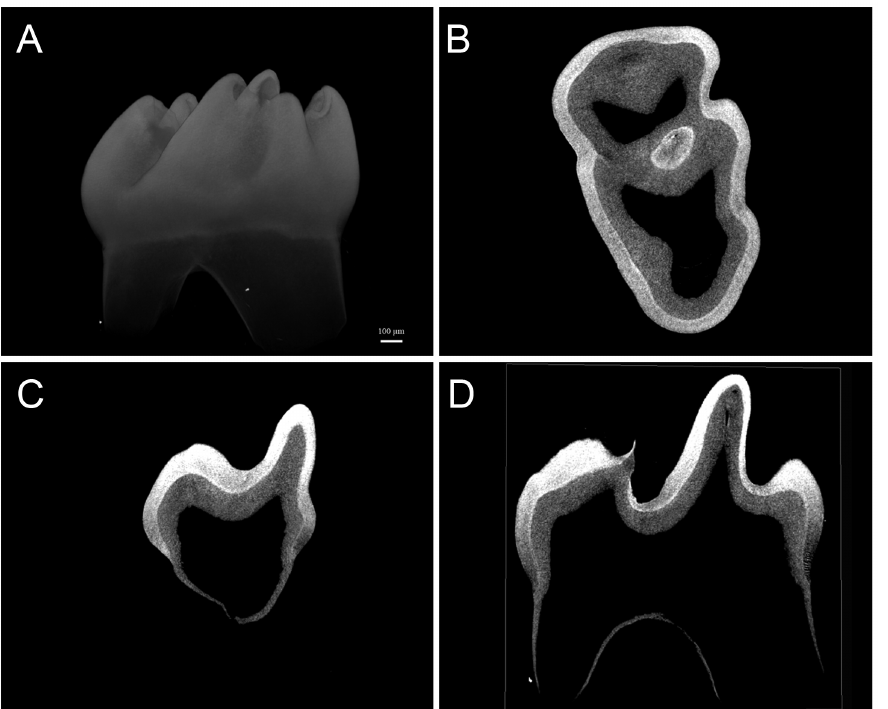
Figure 2. Insitu derived 2-week old mandibular first molar. Micro-CT 3D image (panel A) and cross-sectional slices (panels B–D) of an in situ collected 2-week old mandibular first molar tooth used for comparison with the kidney capsule grown teeth. Avizo software was used to analyze m CT data. Scale bar shown in panel A is 100.0 m m and is common to panels A–D.